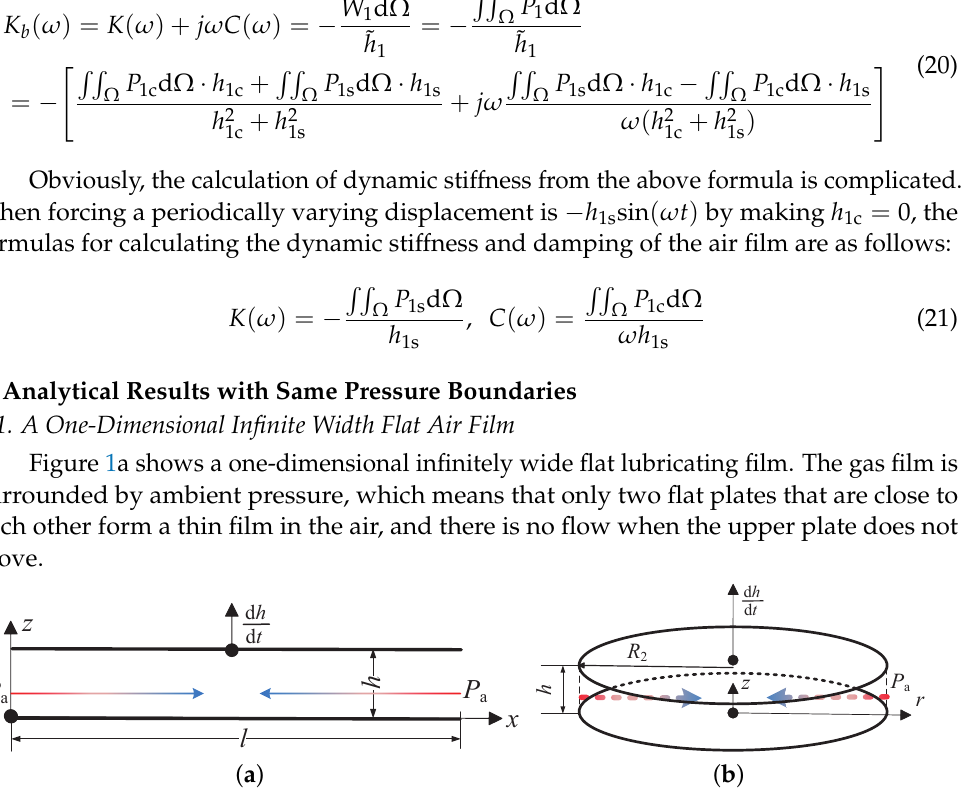
Figure 1. Squeeze film of the one-dimensional constant gap flow model: ( a ) infinite width flat air film; and ( b ) circular air